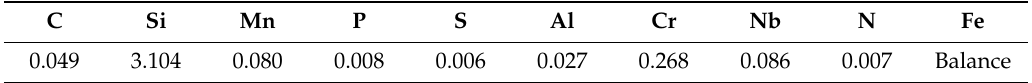
Table 1. Chemical composition of the samples /